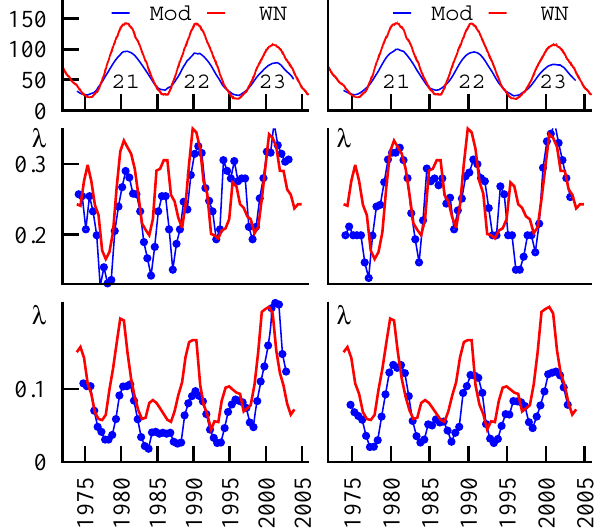
Figure 9. Top row panels: two synthetic signals (blue; see text) and ISSN (red) averaged over 4 years. The two columns of the figure are relative to different synthetic signals. The irregularity index ( m =2) for model (blue) and ISSN (red) series are shown averaged over 162 (middle row) and 648 days (bottom row). a =0.9, h =0.4, and k =0.